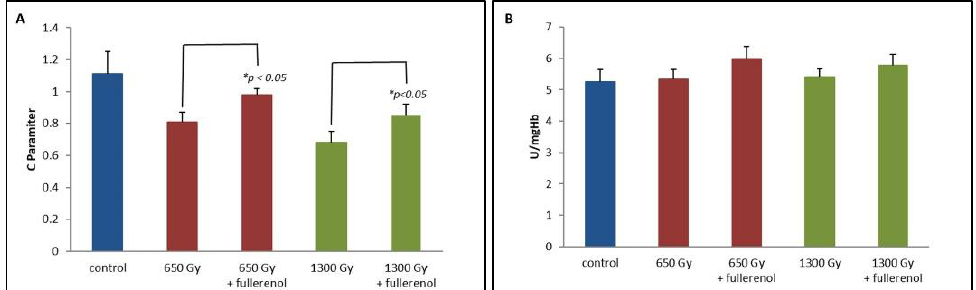
Figure 1. ( A ) The influence of fullerenol on the C parameter determined using the RSSR spin tracer. Fullerenol at a concentration of 150 µg/mL was added to the erythrocyte suspension 1 h before the irradiation with doses of 650 and 1300 Gy. Measurements were performed 2 h after irradiation. The bars represent mean values ± SD for 3 independent measurements. ( B ) The effect of fullerenol on catalase (CAT) activity. Fullerenol at a concentration of 150 µg/mL was added to the erythrocyte suspension 1 h before the irradiation with a dose of 650 or 1300 Gy. Measurements were taken 2 h after the irradiation and haemolysis. The bars represent mean values ± SD for 3 independent measurements. * Statistically significant values at p < 0.05.